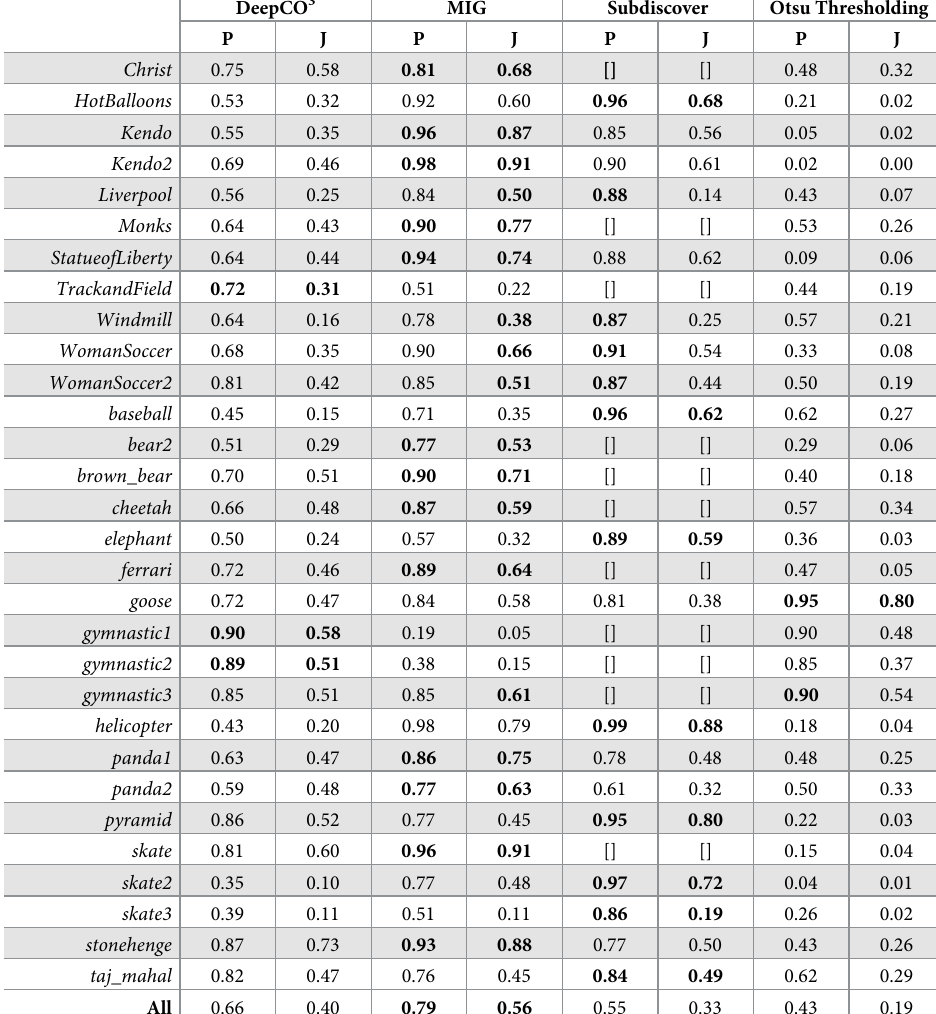
Table 3. Results of three cosegmentation methods and one plant phenotyping segmentation method on the iCoseg